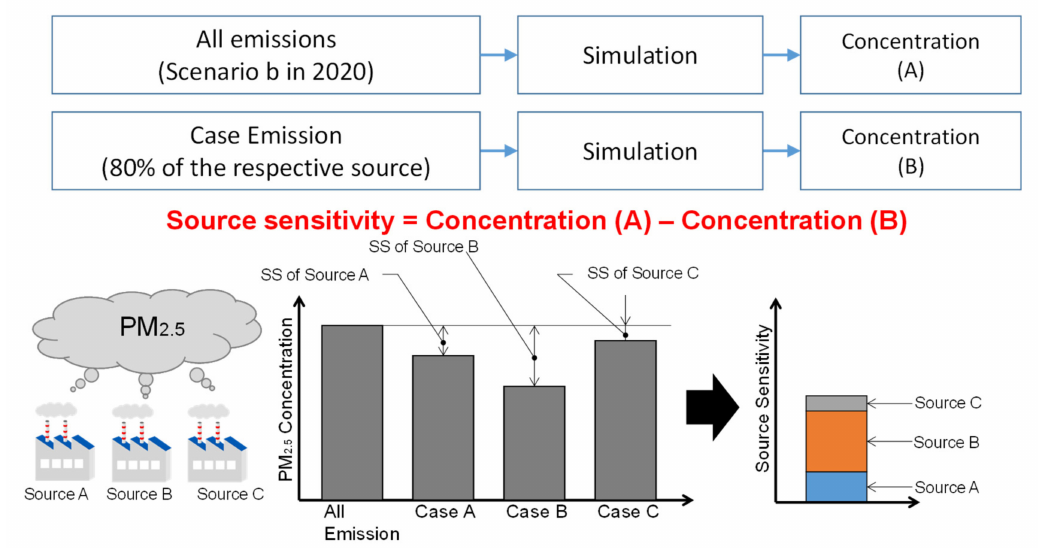
Figure 15. JATOP source sensitivity analyses.